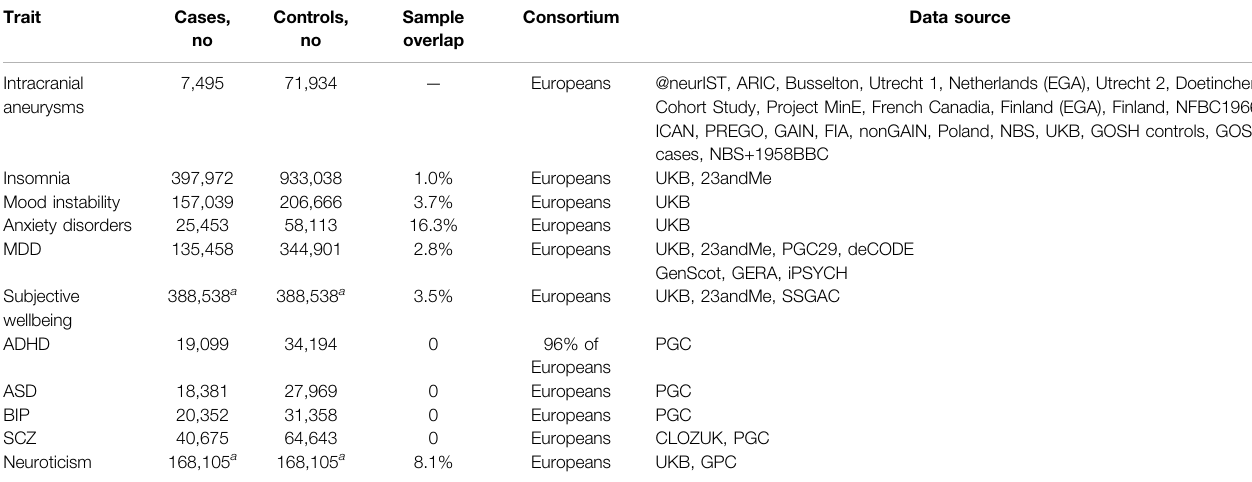
TABLE 1 | Details of GWAS phenotypes utilized for each trait.